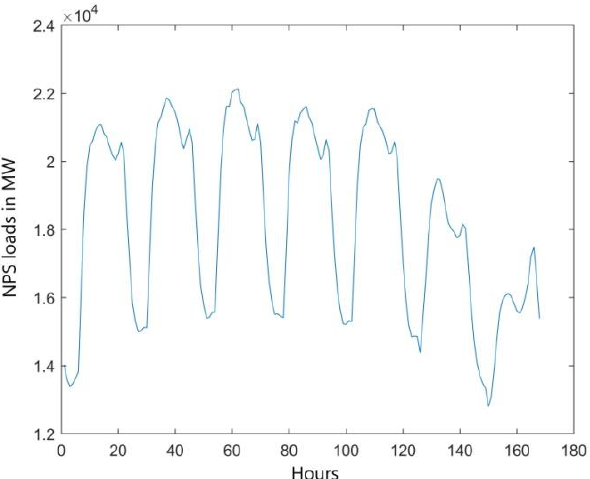
Figure 2. Weekly variability of loads at NPS in Poland from Monday to Sunday 5–11 August 2019 (Source: own work based on PSE-Operator S. A. http://www.pse-operator.pl).